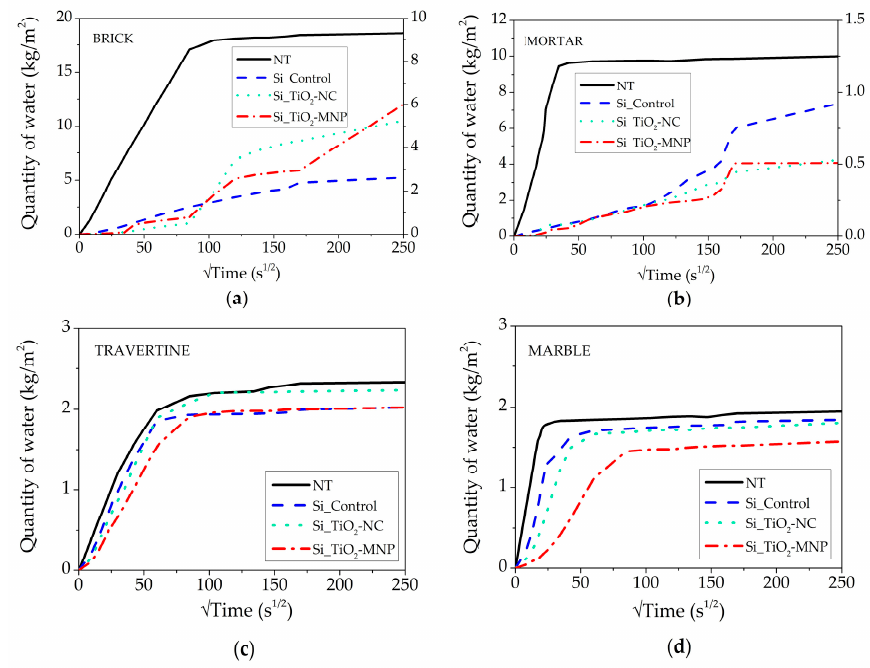
Figure 1. Quantity of water uptake versus time: ( a ) brick, ( b ) mortar, ( c ) travertine, and ( d ) Carrara marble. NT: untreated samples; Si_Control: coating without nanoparticles; Si_TiO 2 -NC: coating with TiO 2 nanoparticles and loaded silica nanocapsules; Si_TiO 2 -MNP: coating with TiO 2 nanoparticles and loaded silica mesoporous nanoparticles. In the case of brick and mortar, data for Si_Control, Si_TiO 2 -NC, and Si_TiO 2 -MNP refer to the right-hand axis scale. All other data refer to the left-hand axis scale.